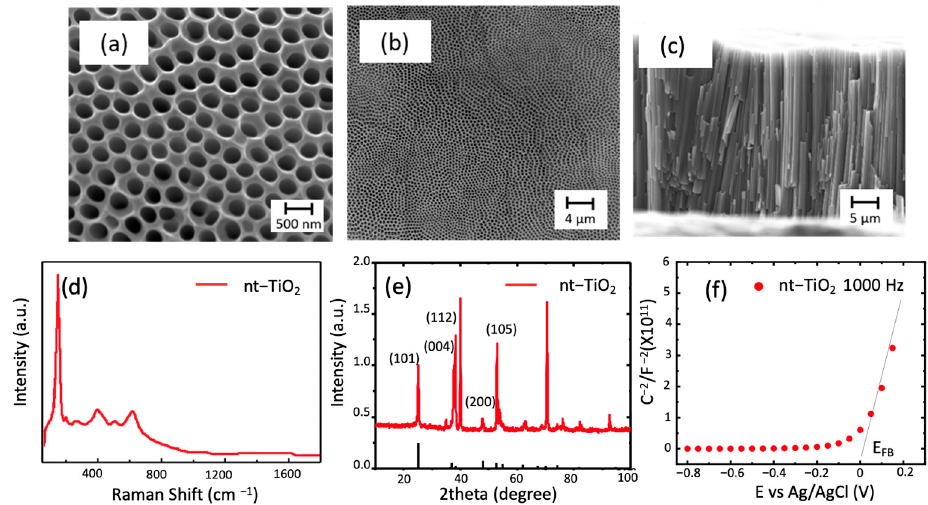
Figure 1. SEM micrographs of the top view of the TiO 2 nanotubes formed by two anodization of titanium foil at 60 V with magnifications of ( a ) 200.000× and ( b ) 26.000×; ( c ) the cross section showing the length of the tubes with magnification of 13.000×; ( d ) Raman spectra of typical nt-TiO 2 obtained; ( e ) diffraction spectra of the nanotubes (in this, the expected position for anatase is observed as black lines) (PDF 1-562); ( f ) Mott–Schottky plot of the sample.